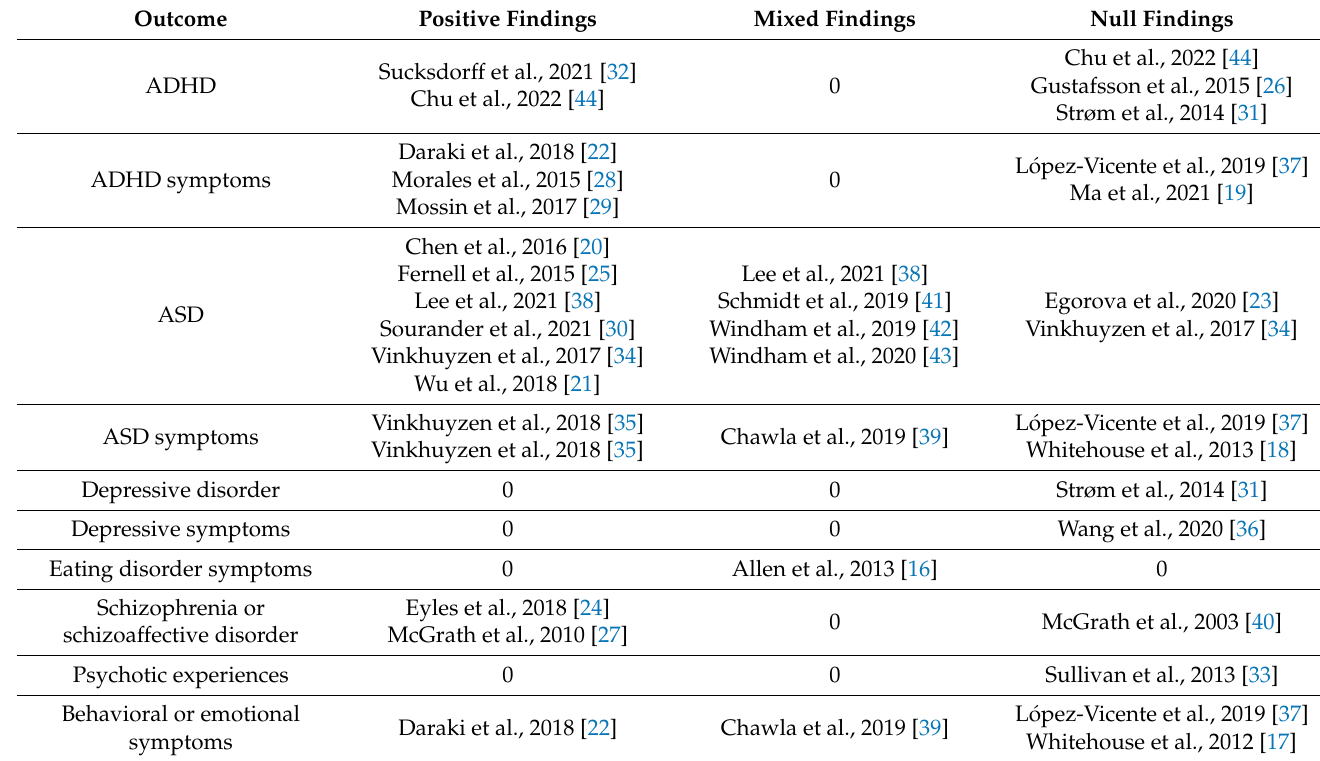
Table 2. Findings of the reviewed studies by each